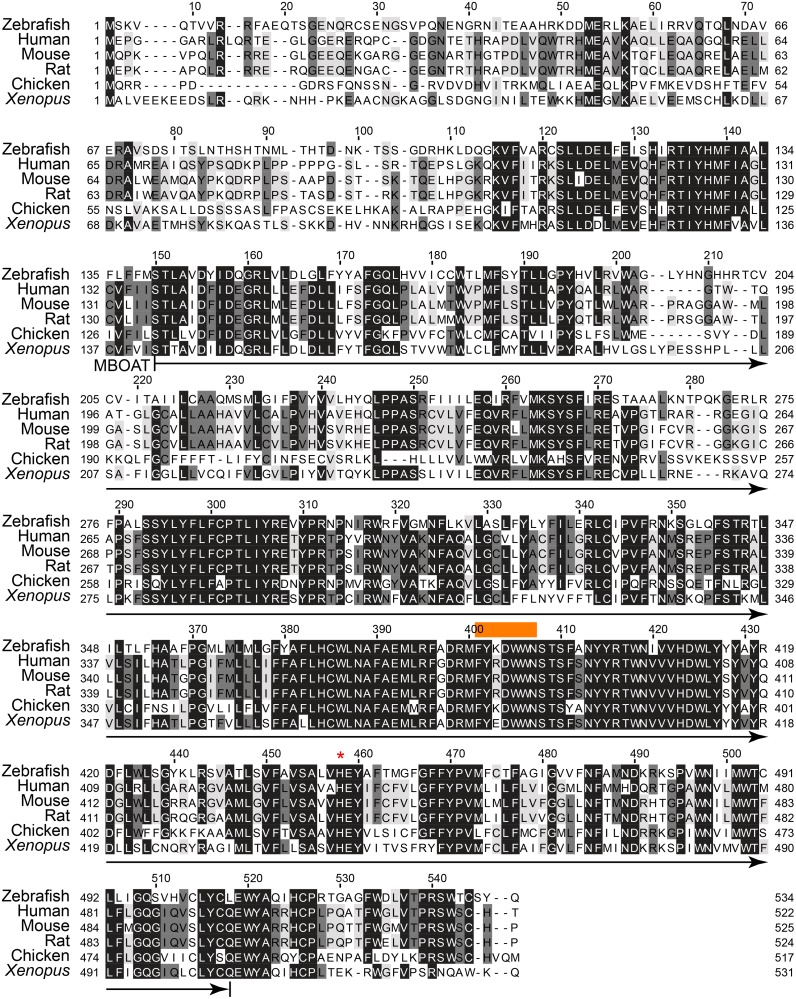
Sequence similarity of Soat2 among various animal species.Zebrafish Soat2 amino acid sequences are aligned with the SOAT2 orthologs from human (ENSP00000301466), rat (ENSRNOP00000015368), mouse (ENSMUSP00000023806), and Xenopus (ENSXETP00000003832). The amino acid sequence of zebrafish Soat2 was predicted according to the cloned sequence. The MBOAT domain is predicted between 140 to 505 residue (arrow under sequences). The acyl-CoA binding domain (FYXDWWN, orange box above the sequences) and the postulated catalytical residue for esterification (His445, red asterike above the sequences) are conservative through species. The identical amino acids are shown in the black box, while the less conservative regions are enclosed by white box.